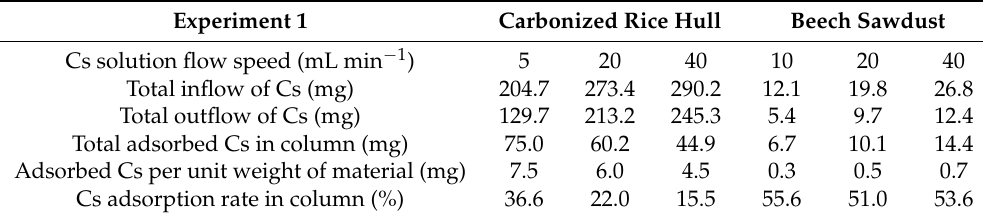
Table 4. Cs mass balance in the packed-bed layer and Cs adsorption rate during experiment